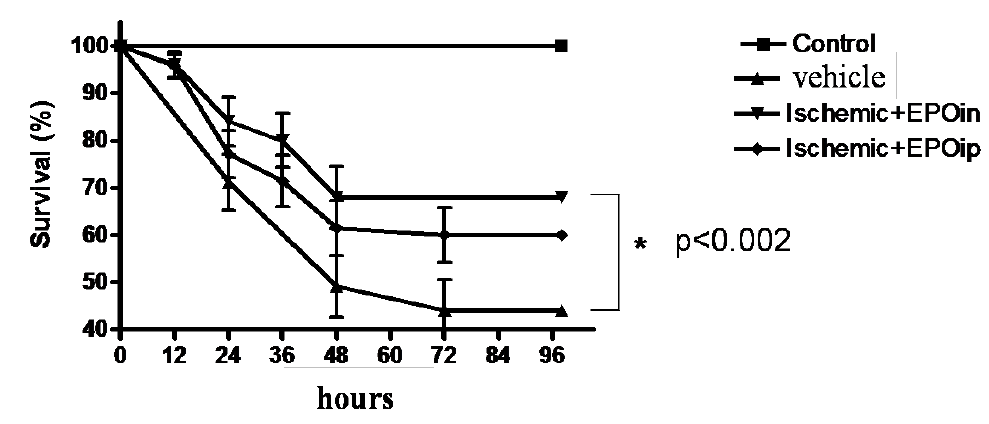
FIGURE 1 . Survival at 7 days from the permanent occlusion of the common right carotid of the gerbils (n = 35 per group). Vehicle was significantly different from Neuro-EPO (* p < 0.002) in the log rank test.